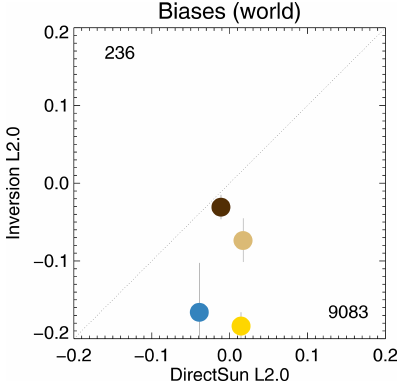
Figure 3. Global biases in four satellite AOD datasets depending on the chosen reference dataset (DirectSun or Inversion). Colours indi- cate the satellite product (see also Fig. 1). Numbers in upper left and lower right corner indicate the amount of collocated data, averaged over all products. Error bars indicate a 5%–95% uncertainty range based on a bootstrap analysis (see Sect. 3.2). Satellite products were individually collocated with AERONET within